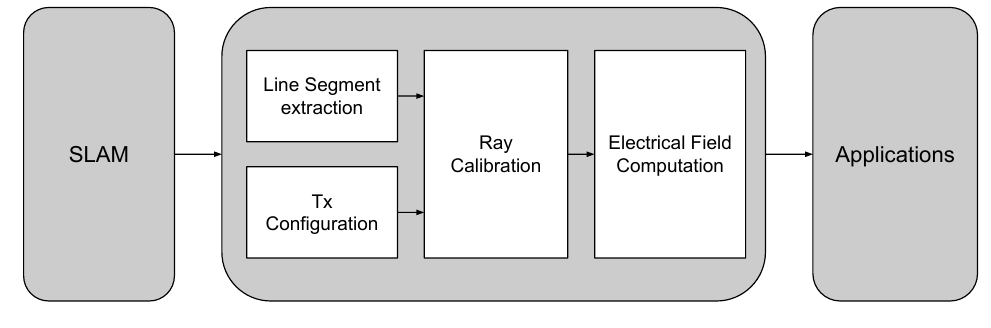
Figure 4. Overview of the ray launching propagation loss